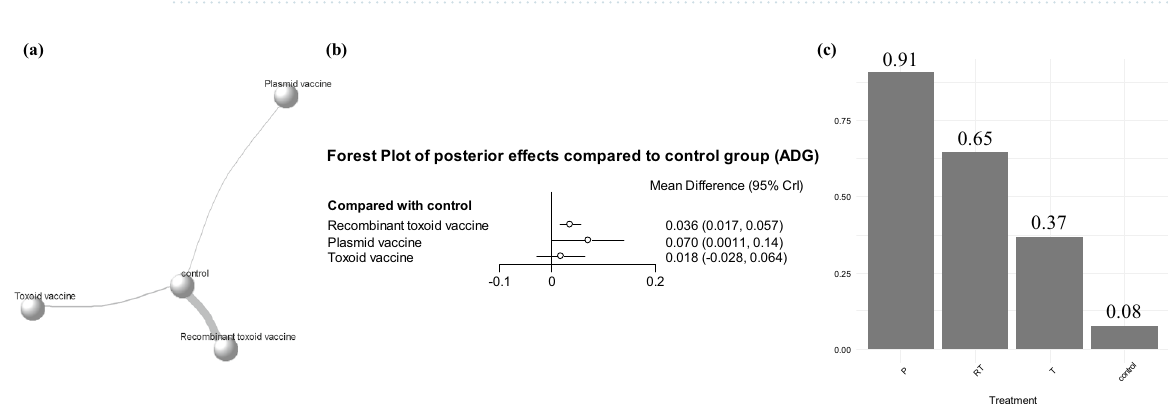
Figure 6. Results of network meta-analysis of edema disease-related clinical symptoms in pigs. ( a ) Network plot for clinical symptoms. Each circle represents a vaccine type, and width of lines between circles indicates number of pairs. ( b ) Forest plot of posterior effects compared to control group based on their odds ratio (OR). ( c ) Surface under the cumulative ranking curve (SUCRA) plot for clinical symptoms. T, toxoid vaccine; AS, anti- serum; P, plasmid-based DNA vaccine; RT, recombinant toxoid vaccine. The statistical program R (version 4.1.1) was used to prepare this figure 44 .